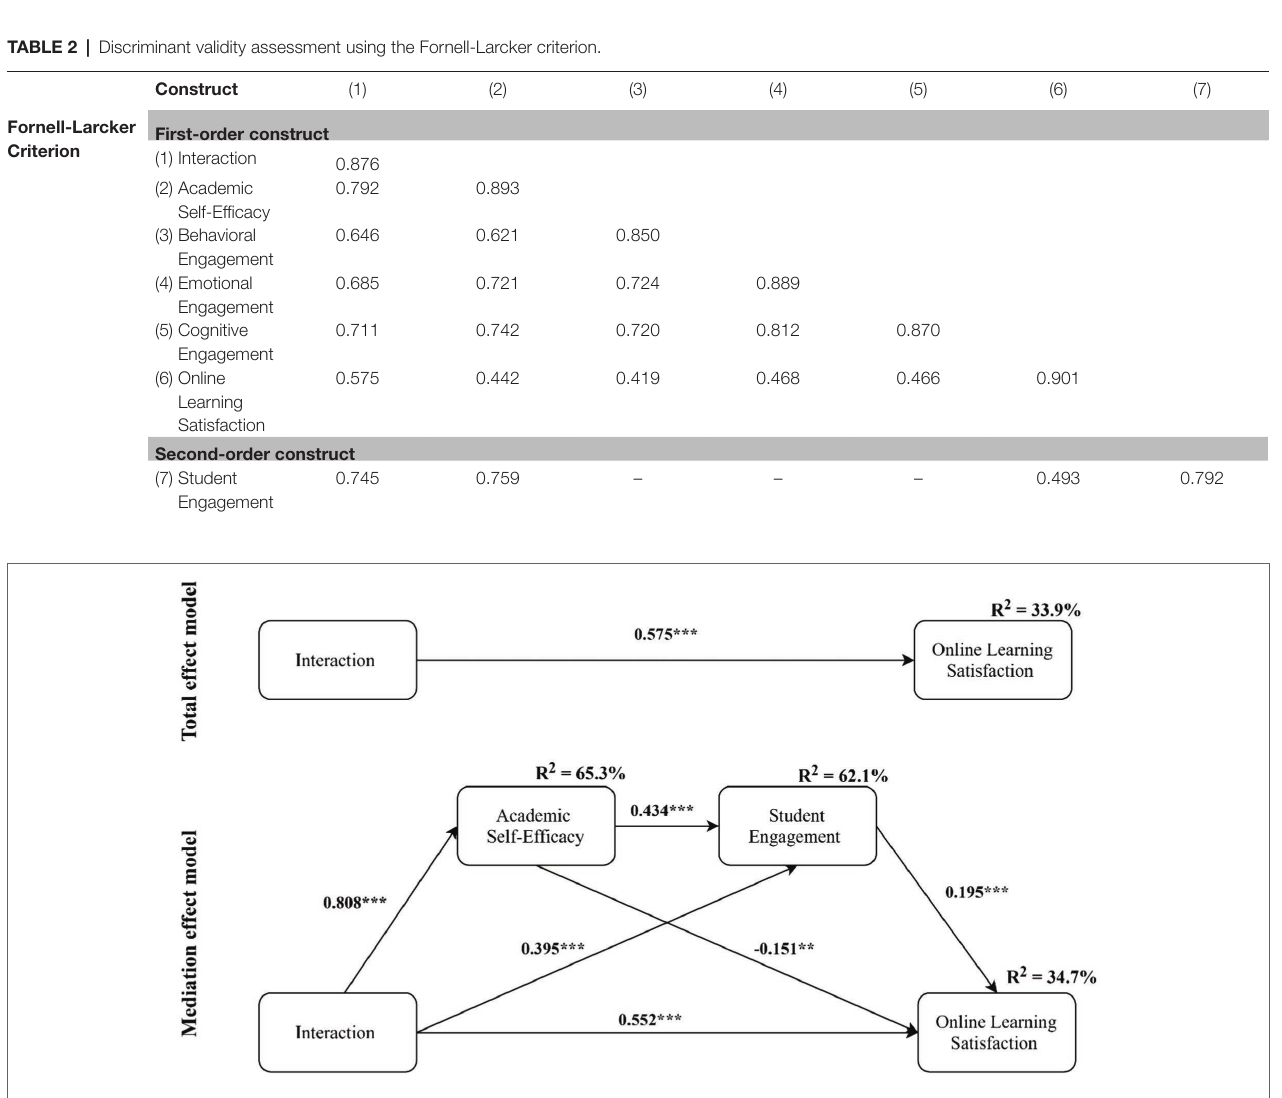
FIGURE 1 | The results of the structural model. *** p < 0.001, ** p < 0.01; model controls age, gender, class per week, and years in